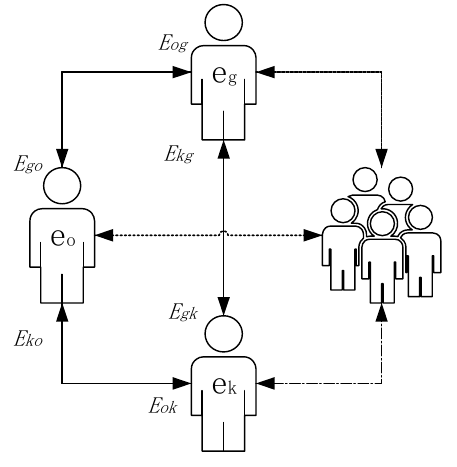
Figure 3. Trust degree among DMs.